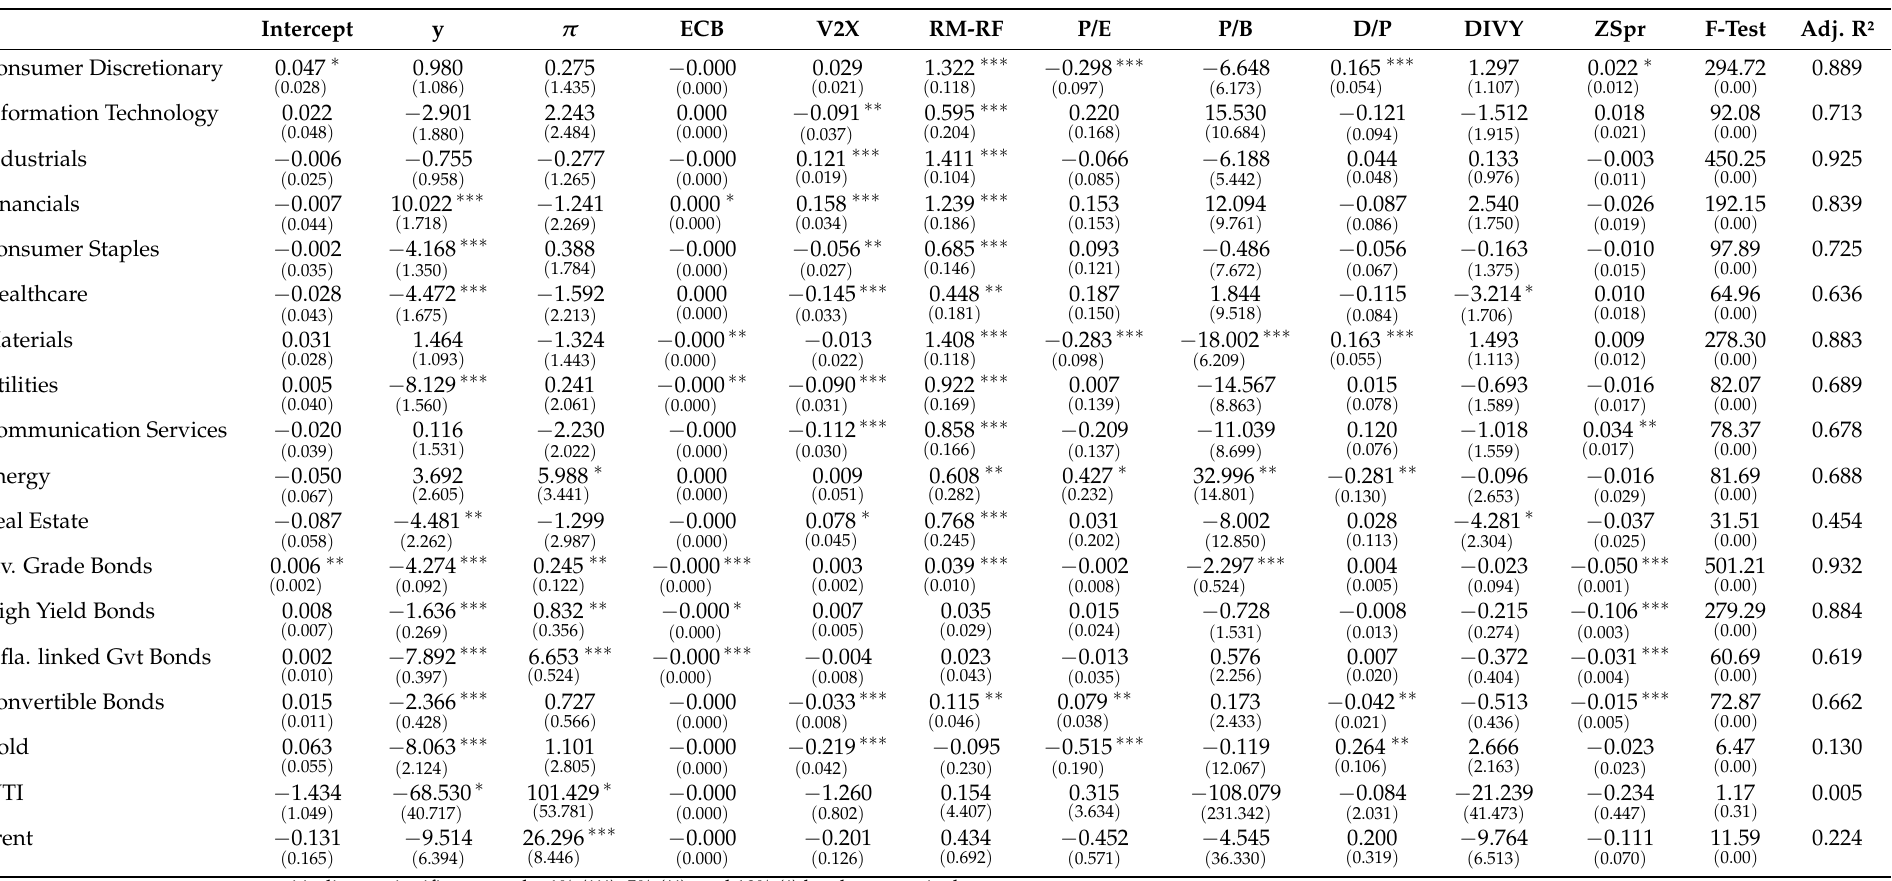
Table A4. Results of regressions conducted for our cross-asset panel for the high volatility regime of inflation expectations from 26 February 2019 to 23 December 2020. Error estimates are indicated in parentheses except for the F-Test, for which the p -value is in